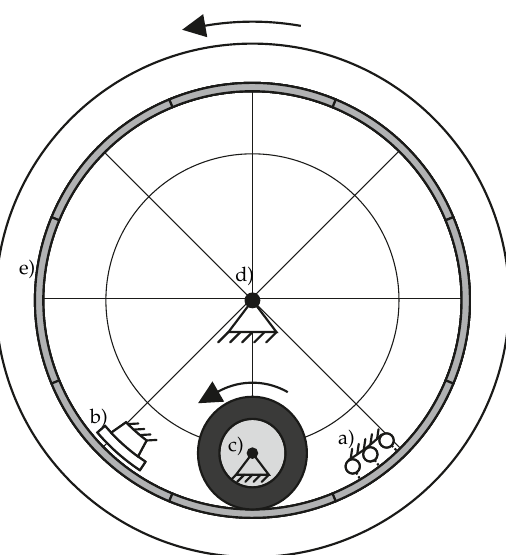
Figure 2. Schematic diagram of the internal drum test rig with water supply ( a ), capacitive water level sensor ( b ), wheel guide ( c ), drum bearing ( d ) and road surface ( e ). The arrows mark the direction of rotation of drum and tire.